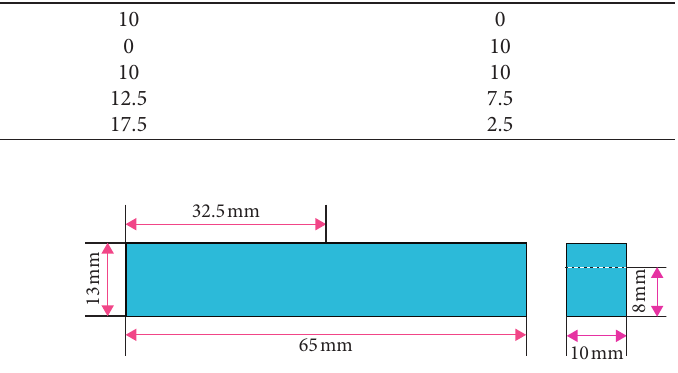
Figure 5: Specimen description for Izod impact test (ASTM D4812 standard).